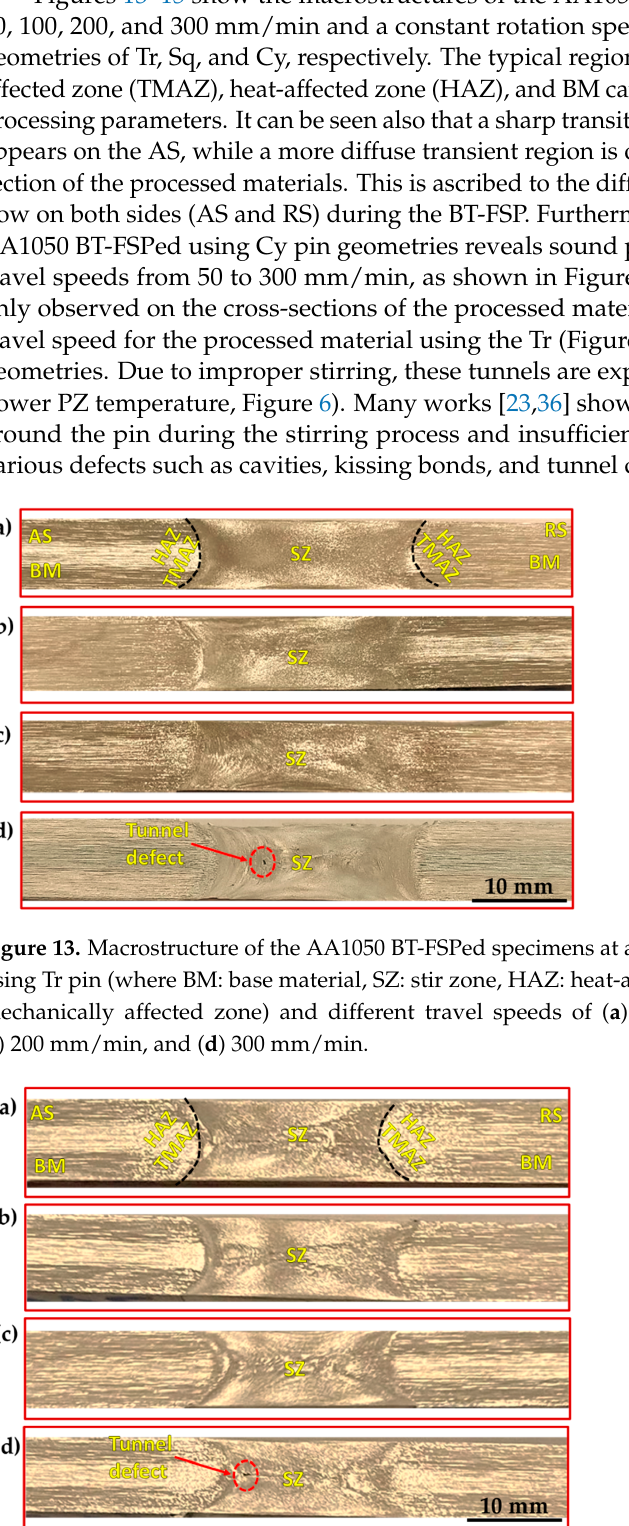
Figure 15. Macrostructure of the AA1050 BT-FSPed specimens at a constant rotation rate of 600 rpm using Cy pin ( where BM: base material, SZ: stir zone, HAZ: heat-affected zone, and TMAZ: thermo- mechanically affected zone) and different travel speeds of ( a ) 50 mm/min; ( b ) 100 mm/min; ( c ) 200 mm/min, and ( d ) 300 mm/min. The PZ areas for all the applied processing conditions are measured and plotted in Figure 16. It can be seen that the PZ areas decrease with the increase in travel speed. In fact, the processing zone area is governed by the amount of heat input introduced to the PZ. The higher the heat input, the higher the material plasticity and the higher the PZ area. The heat input increases with decreasing the travel speed. Thus, the maximum PZ areas of 214.80, 185.18, and 178.40 mm 2 are observed at a 50 mm/min lower travel speed using the Tr, Sq, and Cy pin geometries, respectively. In contrast, the minimum PZ areas of 201.42, 142.71, and 138.15 mm 2 of AA1050 BT-FSPed at a higher travel speed of 300 are obtained using Tr, Sq, and Cy pin geometries, respectively.